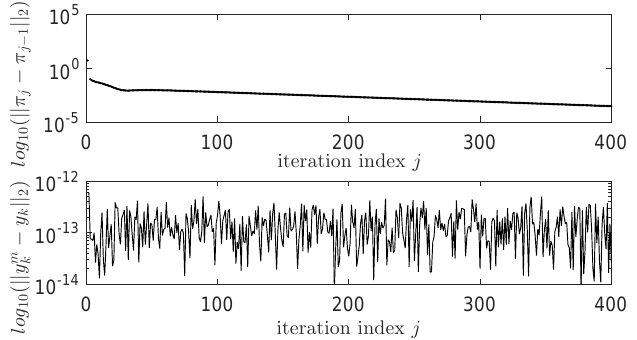
Figure 2. Convergence results of the linearly paramaterized iterative model-free approximate Value Iteration (LP-IMF-AVI) for the linear process